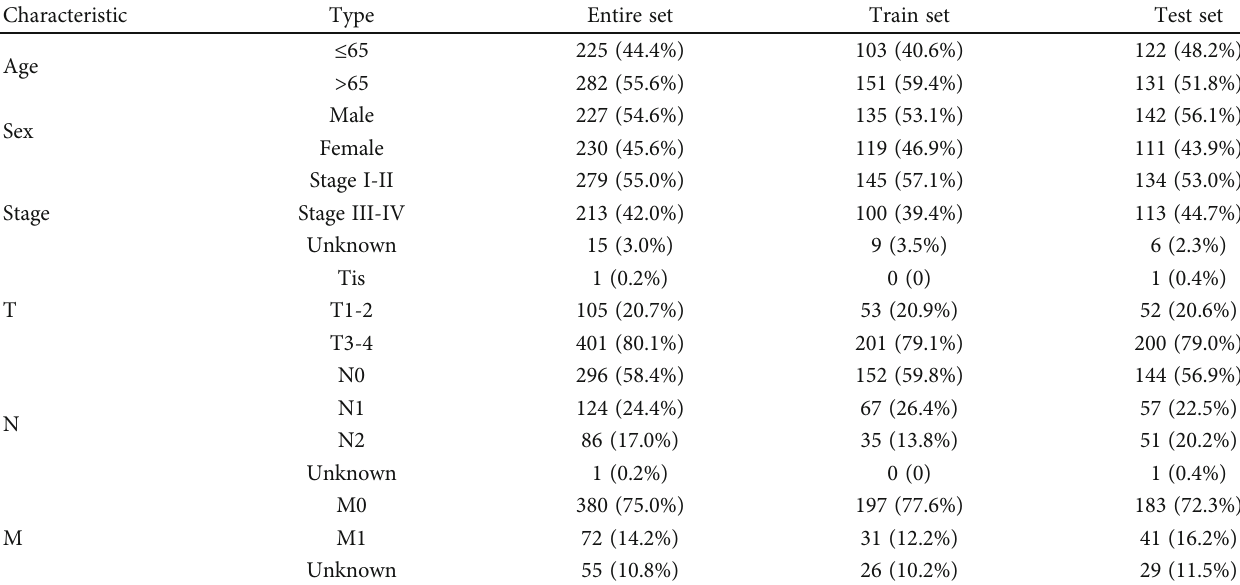
Table 1: The clinical information in train set, test set and entire set.